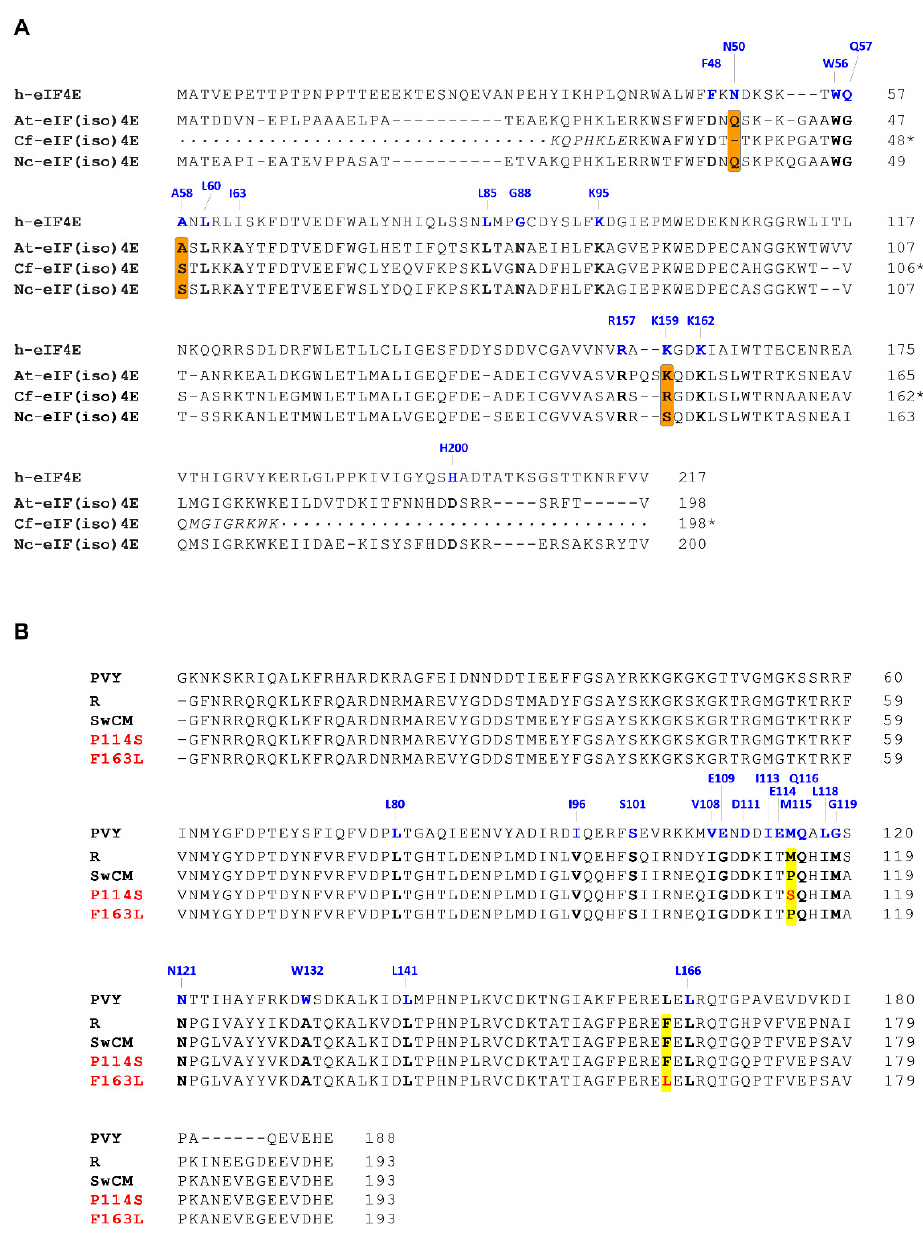
Figure 5. ( A ) Alignment of the translation initiation factors 4E from Homo sapiens (h-eIF4E) (P06730.2) along with eIF(iso)4Es from Arabidopsis thaliana [At-eIF(iso)4E] (O04663.2), Chenopodium foetidum [Cf-eIF(iso)4E] (partial sequence specifically obtained for this study) and Nicotiana clevelandii [Nc-eIF(iso)4E] (KC625579.1). Residues of eIF(iso)4E plant factors aligning with those interacting residues of h-eIF4E appear in bold and, in case of no conservation among the three plant species, are orange highlighted. Amino acids encoded by primers used for PCR amplification of the Cf-eIF(iso)4E sequence are italicized. Asterisks in the numbering of the partial Cf-eIF(iso)4E sequence indicate that for the count, missing amino acids were replaced by the equivalent ones from the full-length sequence of the Chenopodium quinoa eIF(iso)4E protein (LOC110697254 and LOC110692931). ( B ) Alignment of VPg sequences from Potato virus Y (PVY) (QED90173.1) and Plum pox virus (PPV), R isolate (EF569215) and SwCMp isolate (SHARCO database, http://w3.pierroton.inra.fr:8060, accessed on 1 April 2021). Two mutations independently arisen at SwCMp VPg, as consequence of the adaptation in A. thaliana , are shown in red over a yellow-shaded box. In both panels, specific amino acids perturbed as a result of interaction between h-eIF4E and PVY VPg, according to Coutinho de Oliveira et al. [51], are highlighted in blue. Residues of PPV VPg aligning with the h-eIF4E -interacting PVY VPg residues appear in bold. Protein sequences were aligned using Clustal Omega program (European Bioinformatics Institute), then adjusted by minor manual